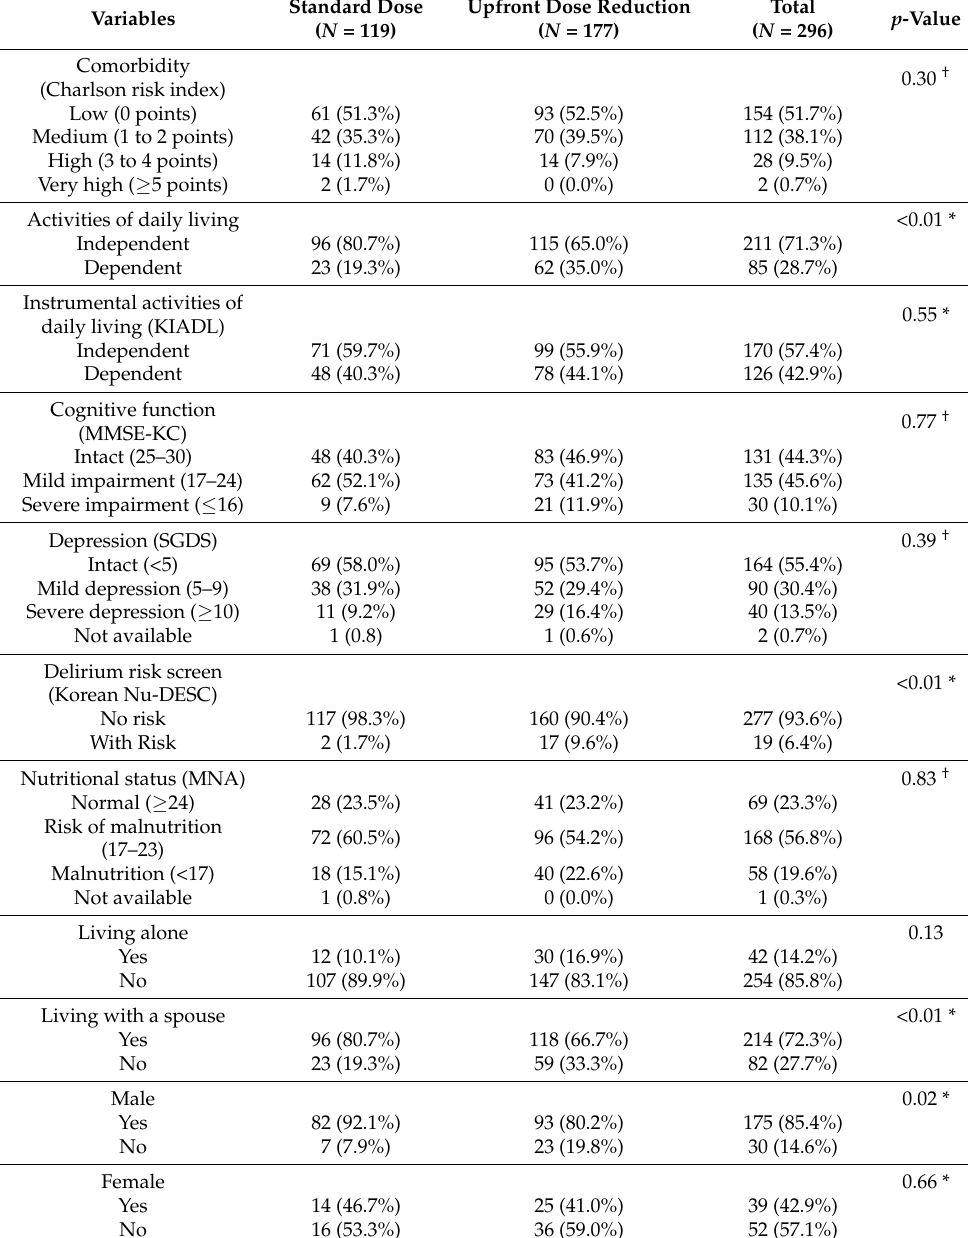
Table 2. Association between upfront dose reduction and variables of geriatric